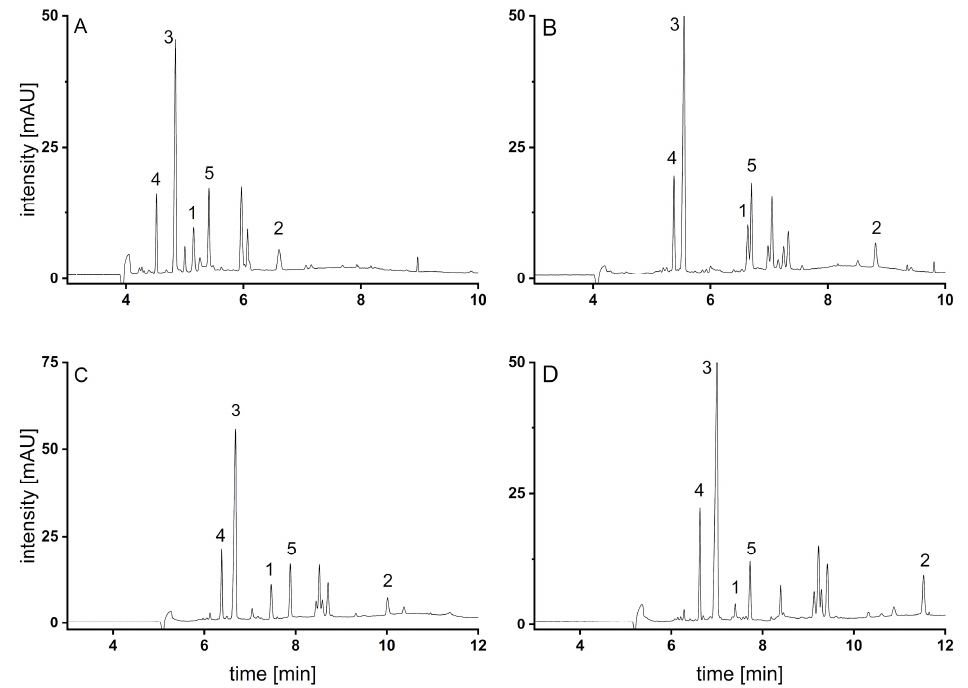
Figure 4. Influence of different parameters on the CE-separation of the test solution: using borate buffers at pH 7.5 ( A ) and 9.0 ( B ), applying 20 kV ( C ), and increasing the isopropanol concentration to 7.5% ( D ). All other parameters were optimal (see Figure 2).